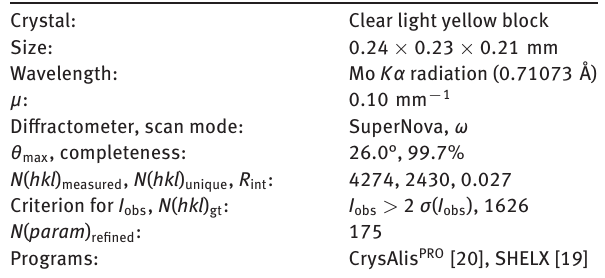
Table 2: Fractional atomic coordinates and isotropic or equivalent isotropic displacement parameters (Å 2